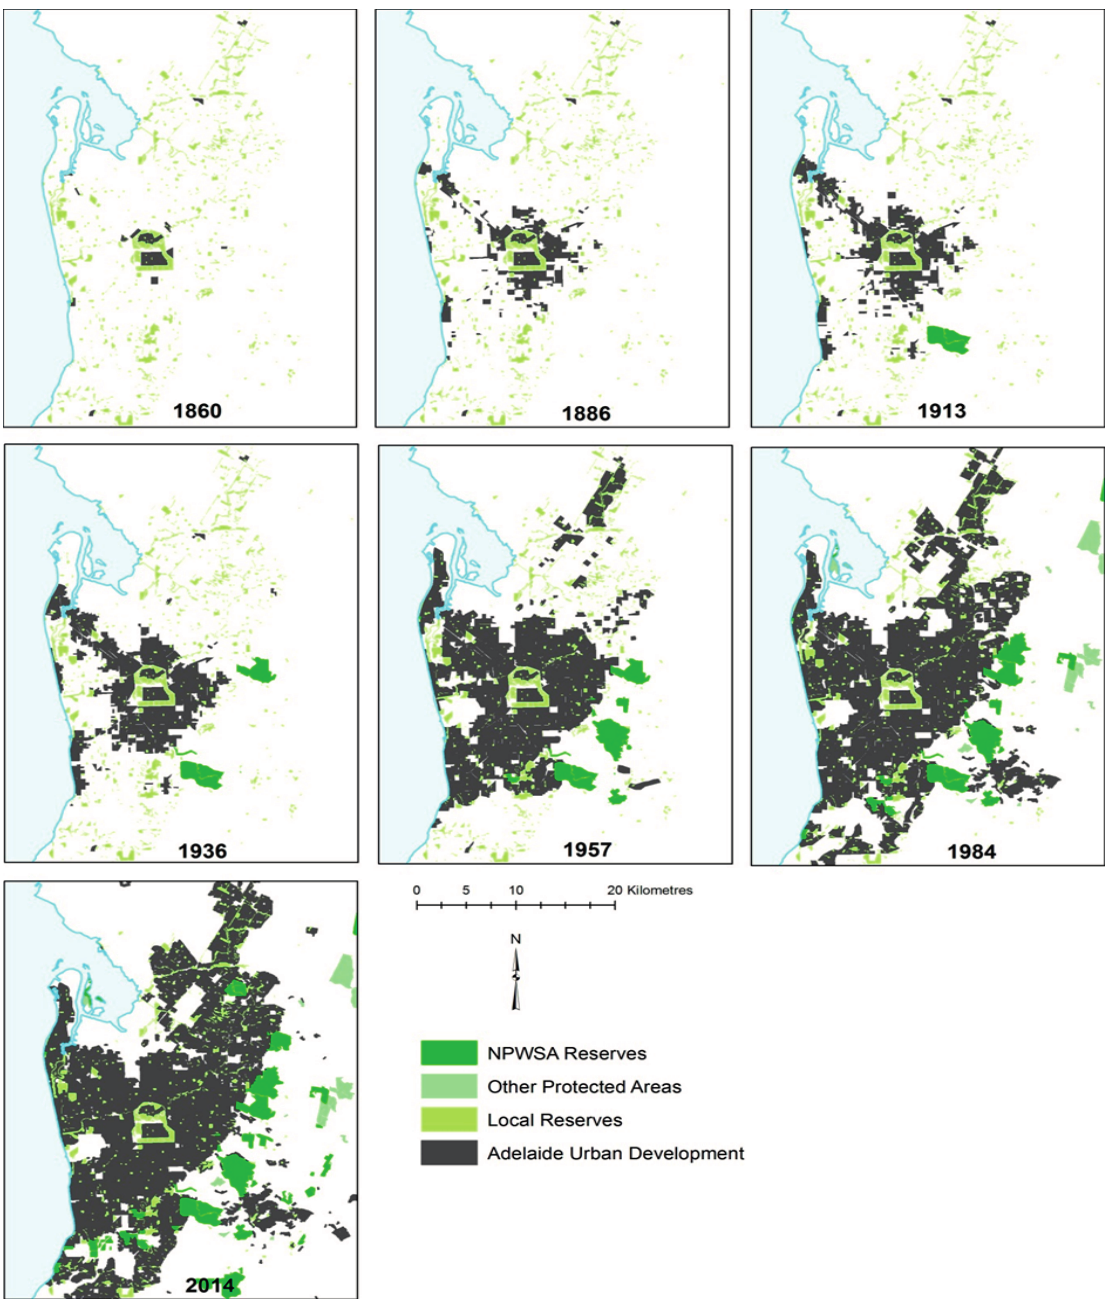
Figure 4. The growth of Adelaide, South Australia, from the time of settlement, 1836 (courtesy of Simeon Telfer [31]). Note the green belt around the more-or-less rectangular city centre in each map. NPWSA: National Parks and Wildlife Service